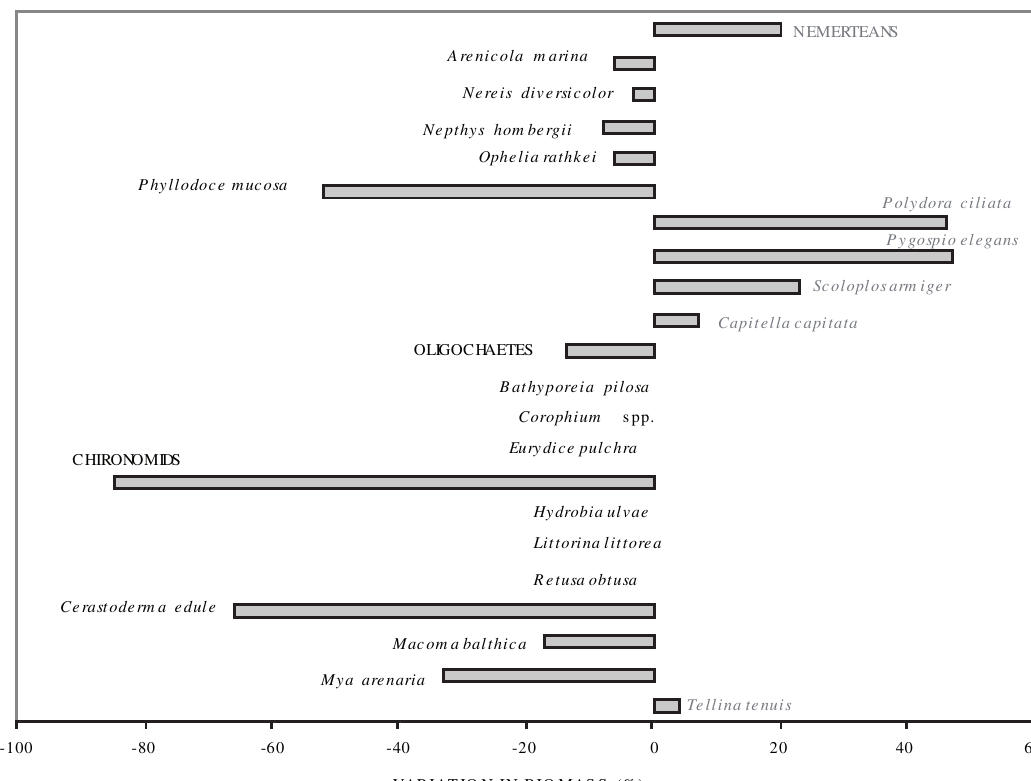
Fig . 10. – Variation in standing stock (biomass) of invertebrates (benthic and small epibenthic amphipods), “before” and “after” the cockle harvesting, which occurred in June 1995.